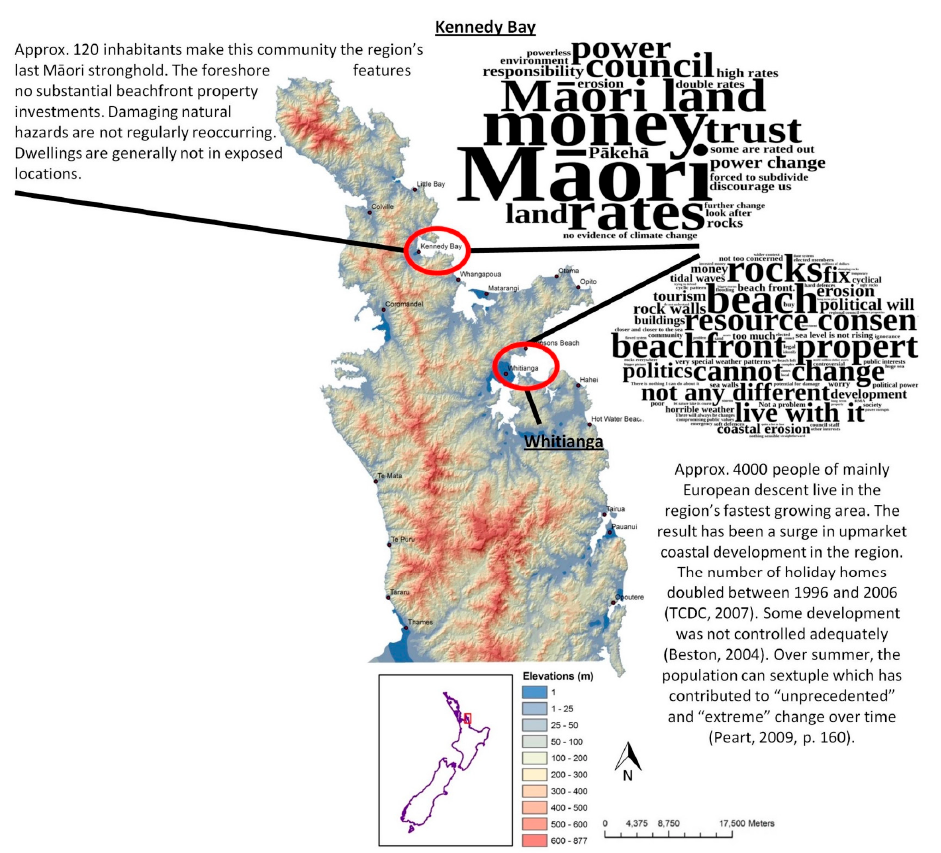
Figure 1. Overview of Kennedy Bay and Mercury Bay and the words most frequently used by research participants in interviews, in word cloud format.